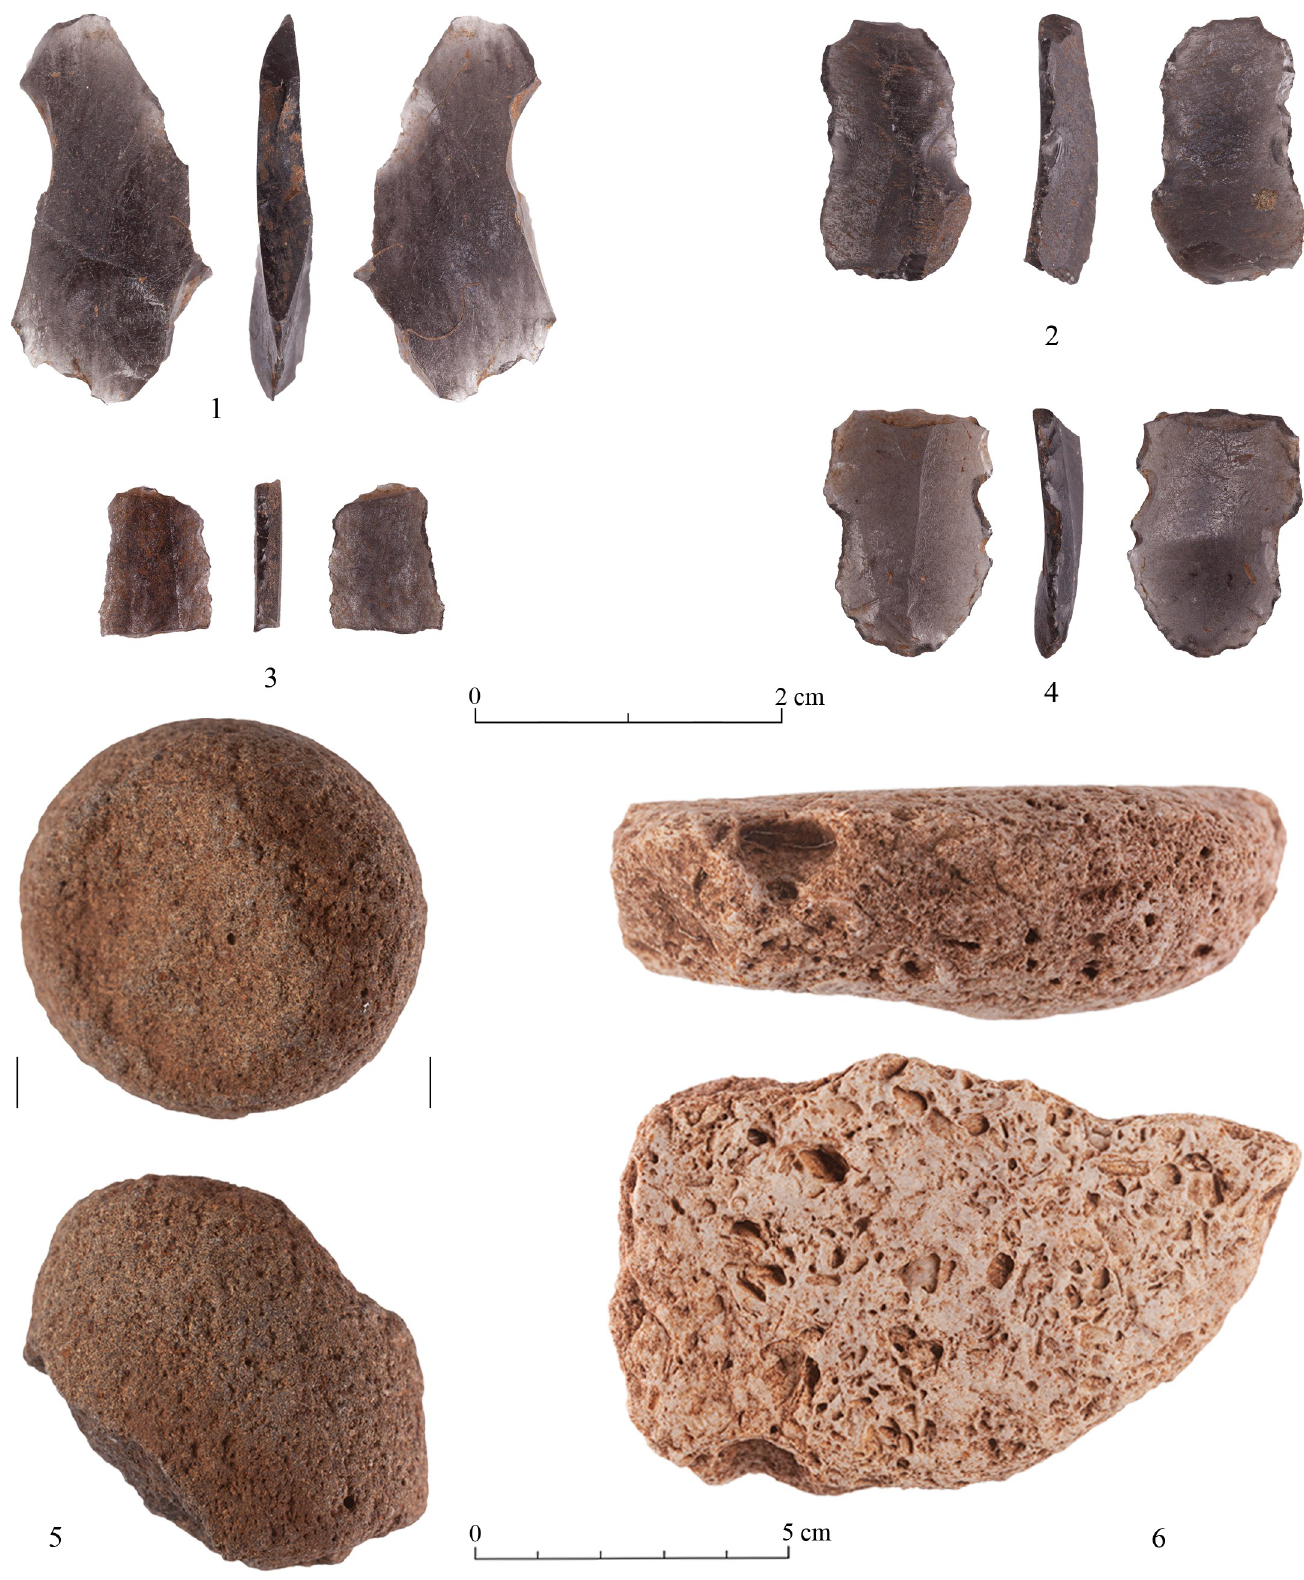
Fig 17. Rare raw materials: 1–4) obsidian—broken blades; 5) basalt—broken pestle; 6) silicified limestone—broken grinding stone.